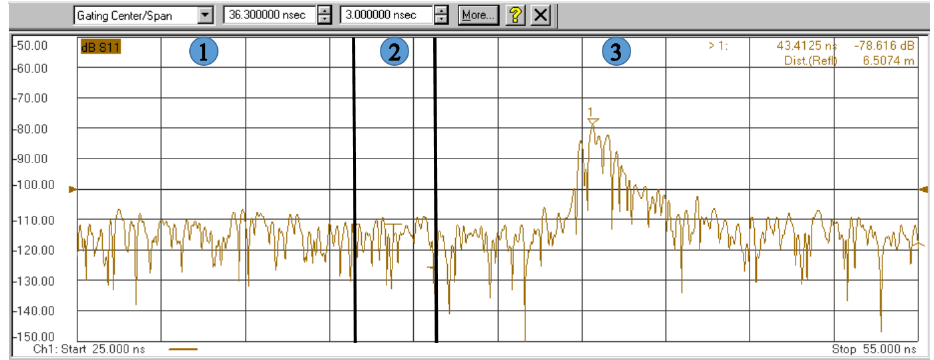
Fig. 3. Reflected signal time domain diagram with parametric reflector in «on» state, made with the measuring bench.